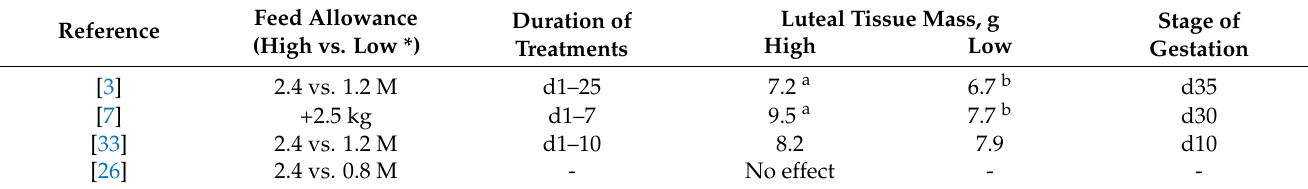
Table 2. Effects of feed allowance (high or low) in early pregnancy on the amount of luteal tissue. Reference (High vs. Low